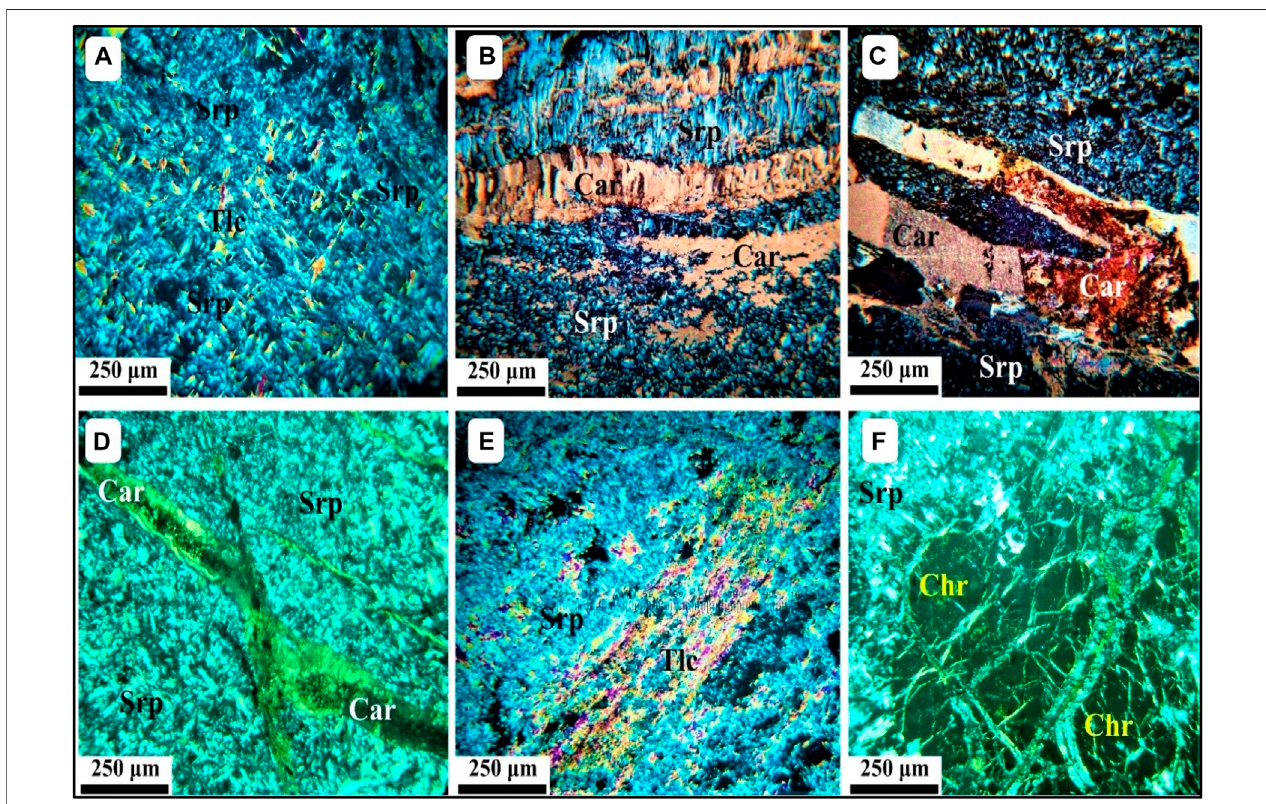
FIGURE 4 | Petrographical features of serpentinite rocks showing: (A) Non-pseudomorphic interpenetrating texture in serpentinites consisting of optically distinguishablebladesofantigorite(Srp)mineralsandtalc(Tlc).C.N. (B) Serpentine(Srp)mineralsaltered tocarbonate(Car).C.N. (C) Twotypesofcarbonates(Car).C. N. (D) Bent of carbonate (Car) result of deformation. C. N. (E) Serpentine (Srp) minerals altered to talc (Tlc). C. N. (F) Coarse anhedral fractured chromite (Chr) crystal. C. N.